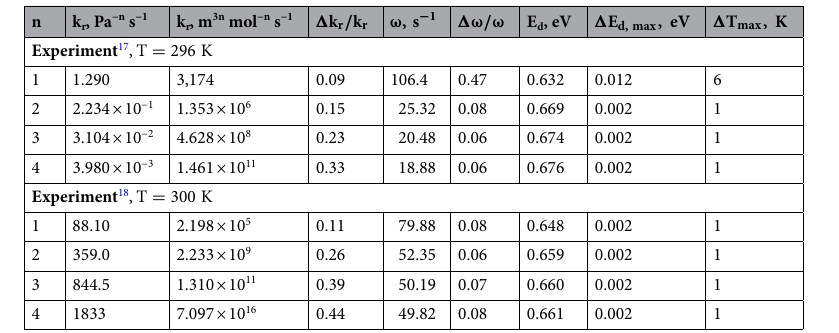
Table 3. The kinetic parameters determined using different partial reaction orders for F atoms.